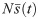
Experimental data and their empirical first- and second-order statistics.(A) Example raster display (snippet of 2s from the total data of 15 min) of N = 159 parallel spike recordings of macaque monkey during a state of “ongoing activity”. The experimental data are recorded with a 100-electrode “Utah” array (Blackrock Microsystems, Salt Lake City, UT, USA) with 400 μm interelectrode distance, covering an area of 4 × 4 mm2 (session: s131214-002). The total activity Ns¯(t) shows the number of active neurons within each time bin t of width Δ = 3 ms. (B) Population distribution of the time-averaged activities mi (in spikes/Δ) of each of the neurons i, Eq (1). The vertical line marks the population average m¯=0.0499. (C) Population distribution of the time-averaged raw correlations (coupled activities) gij, Eq (2). The vertical line marks the population average, g¯≔2N(N-1)∑i<jgij=0.00261. (D) Population distribution of the covariances cij = gij − mimj. The vertical line marks the slightly positive population average, c¯≔2N(N-1)∑i<jcij=0.000135. Histograms bins in B, C, D are computed with Knuth’s rule [92] and calculated over the full 15-minute long recording. Data courtesy by A. Riehle and T. Brochier.